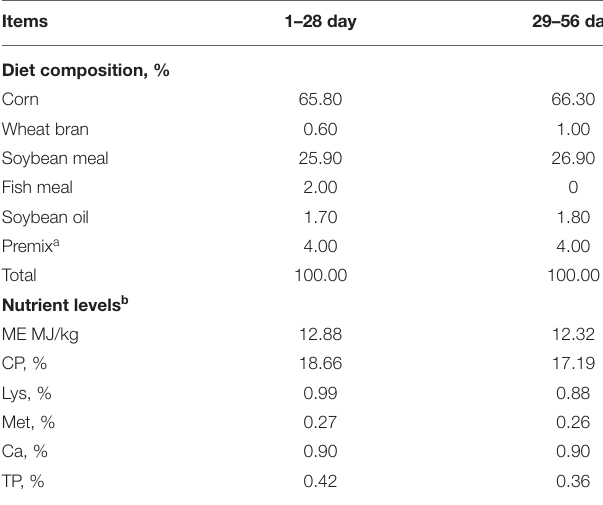
TABLE 1 | Composition and nutrient levels of basal